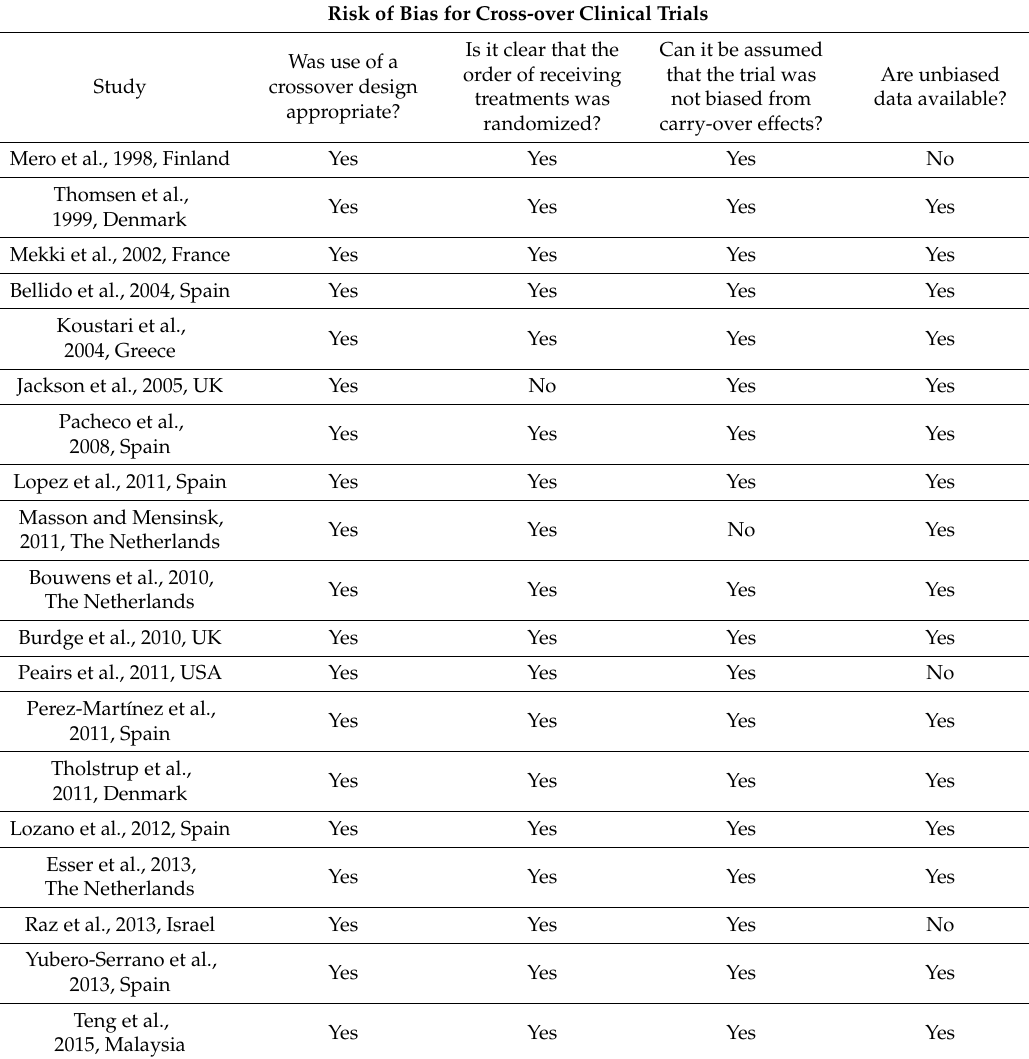
Table 2. Risk of bias of included studies in the